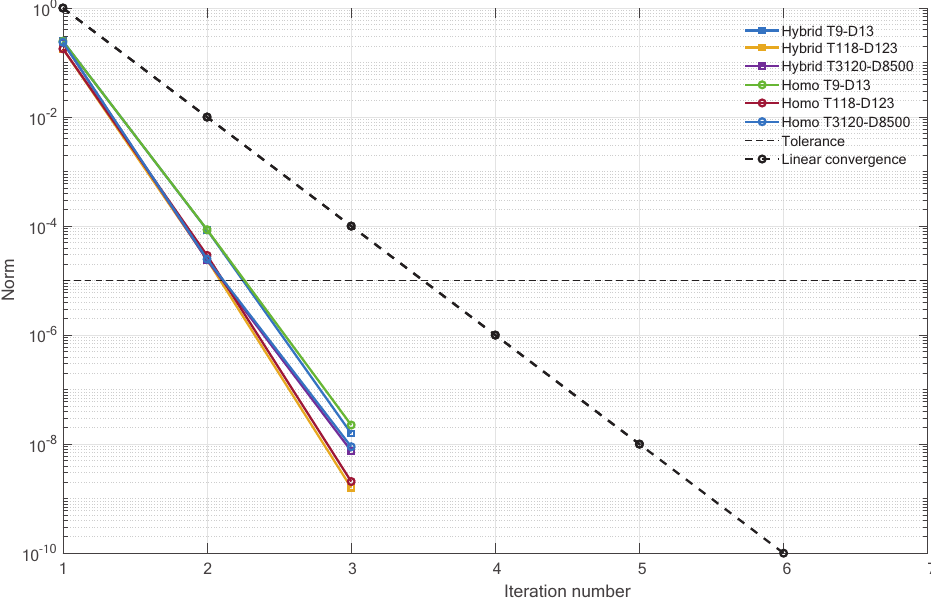
| − V ν 1 , per iteration, of the splitting meth- B B